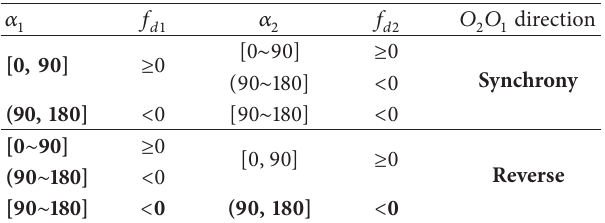
Table 1: Data range of direction angles and frequency